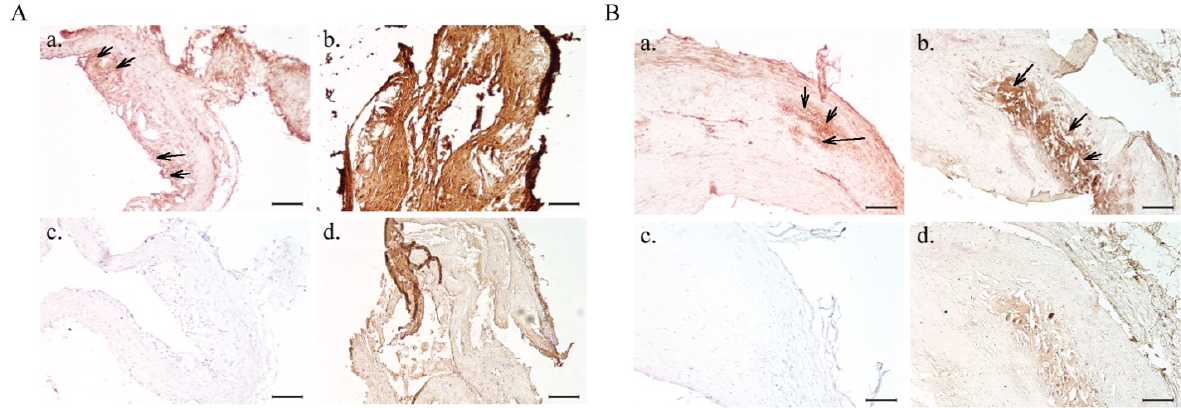
Figure 3. IHC analysis of aorta sections from hypercholesterolemic Apoe − / − mice ( A ) and human endarterectomy samples ( B ). NE-P3 (#5) can recognize galectin-3 in mouse aorta sections ( Ab ) and in human samples ( Bb ). No signal was observed with NE–PEG 3400 –maleimide (#3) (without antibody) ( Ad , Bd ) and in the negative control (secondary antibody only: Ac , Bc ). Unconjugated scFv-Fc-2Cys P3 ( Aa , Ba ) was used as a positive control. Black arrows highlight specific binding by P3 or NE-P3 (#5). Scale bar: 250 µm (upper panels) and 100 µm (lower panels). Two tissue blocks were used for mouse aorta sections labeling in Panel A (one for a and c, and another for b and d). The same tissue block from the same patient was used in Panel B. The mouse aorta and endarterectomy sections shown are representative images taken from successive stained sections. Three independent experiments were performed with these formulations (a section per formulation).